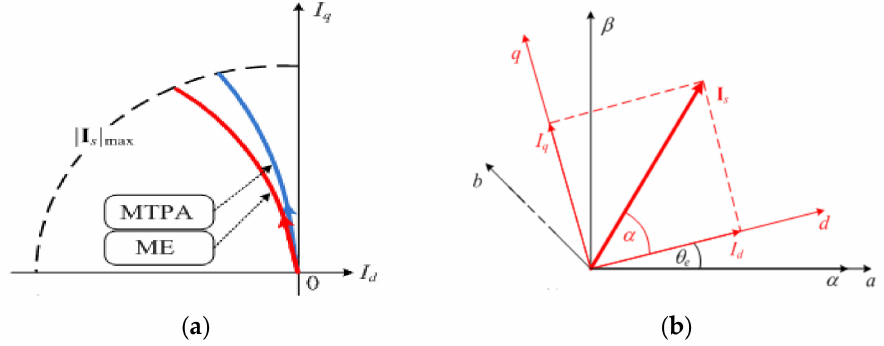
Figure 1. Maximum torque per ampere (MTPA) and maximum e ffi ciency (ME) characteristics ( a ) and stator current vector in α - β and d-q reference frame ( b